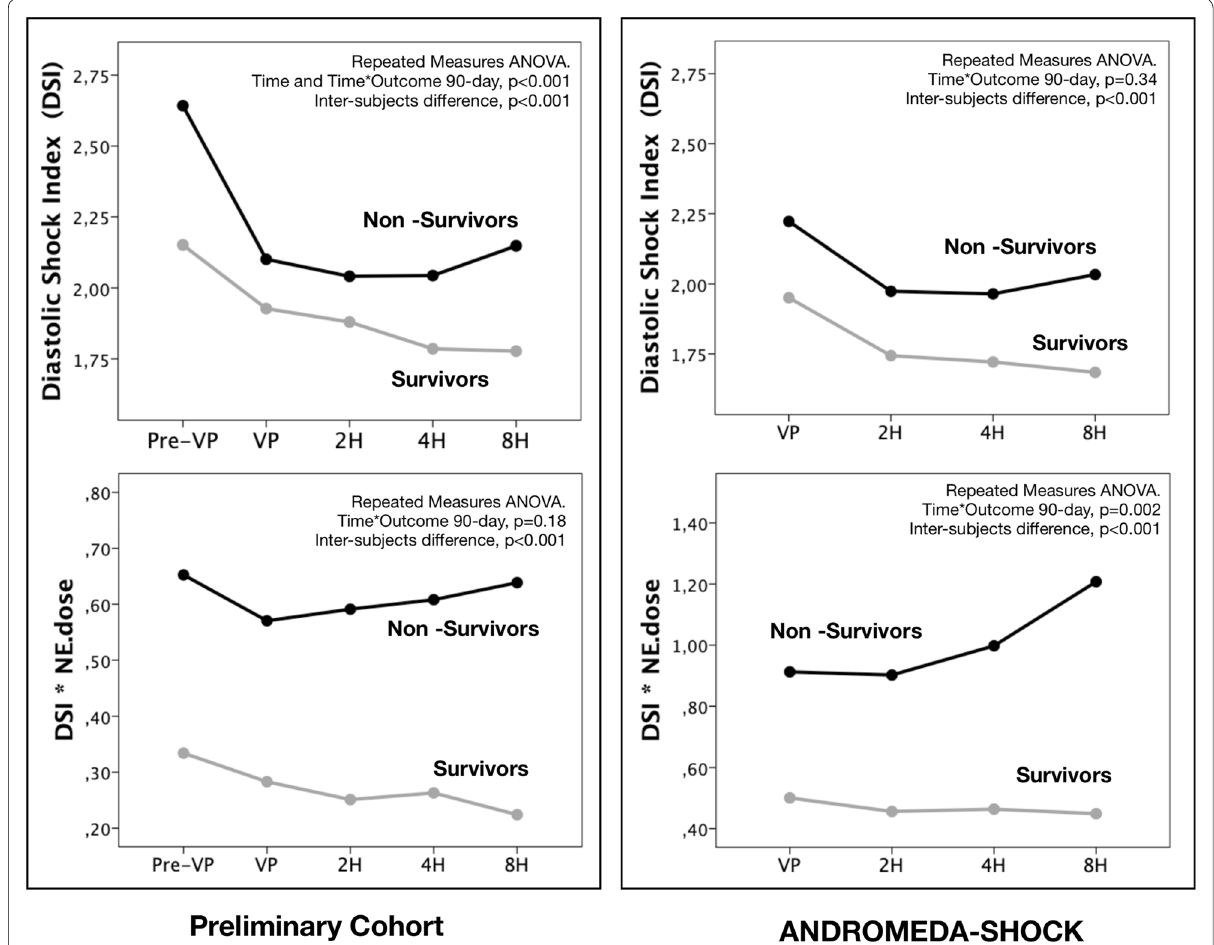
Fig. 4 Time‑course of diastolic shock index (DSI) and the interaction between DSI and norepinephrine dose for survivors and non‑survivors at day‑90 in the preliminary cohort and ANDROMEDA‑SHOCK. Left panel, Top. Time‑course of DSI for survivors and non‑survivors at day‑90 in the preliminary cohort. Repeated‑measures ANOVA, Time*Outcome day‑90, p < 0.001. Inter‑subjects difference, p < 0.001. Left panel, Bottom. Time‑course of interaction of DSI and norepinephrine dose for survivors and non‑survivors at day‑90 in the preliminary cohort. Repeated‑measures ANOVA, Time*Outcome day‑90, p 0.18. Inter‑subjects’ difference, p < 0.001. Right panel, Top. Time‑course of DSI for survivors and non‑survivors = at day‑90 in ANDROMEDA‑SHOCK population. Repeated‑measures ANOVA, Time*Outcome day‑90, p 0.34. Inter‑subjects difference, p < 0.001. = Right panel, Bottom. Time‑course of interaction of DSI and norepinephrine dose for survivors and non‑survivors at day‑90 in ANDROMEDA‑SHOCK population. Repeated‑measures ANOVA, Time*Outcome day‑90, p 0.02. Inter‑subjects’ difference, p < =